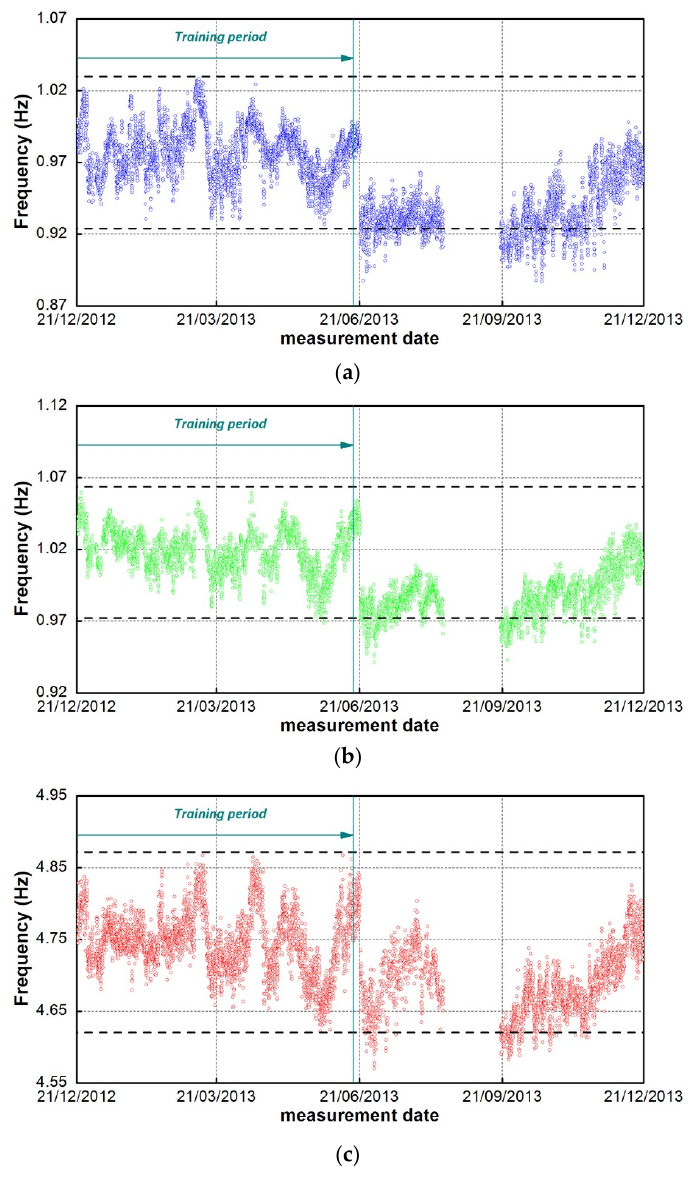
Figure 15. Change in the cleaned natural frequency (Dynamic Regression model) induced by the seismic event of 21/06/2013: ( a ) Mode B 1 ; ( b ) Mode B 2 ; and ( c ) Mode T 1 .